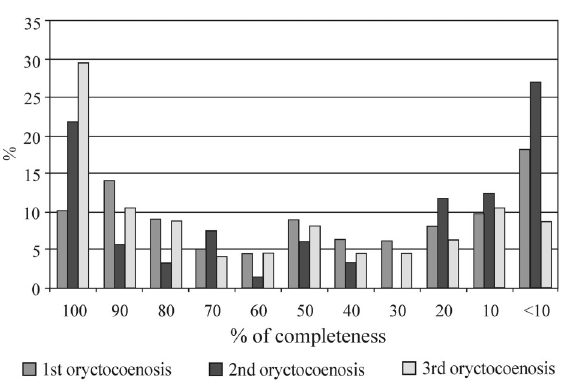
Fig. 4. Proportions of intact and broken skeletal elements from the three oryctocoenoses, Kl ū nas site, according to data of excavations of 2010.